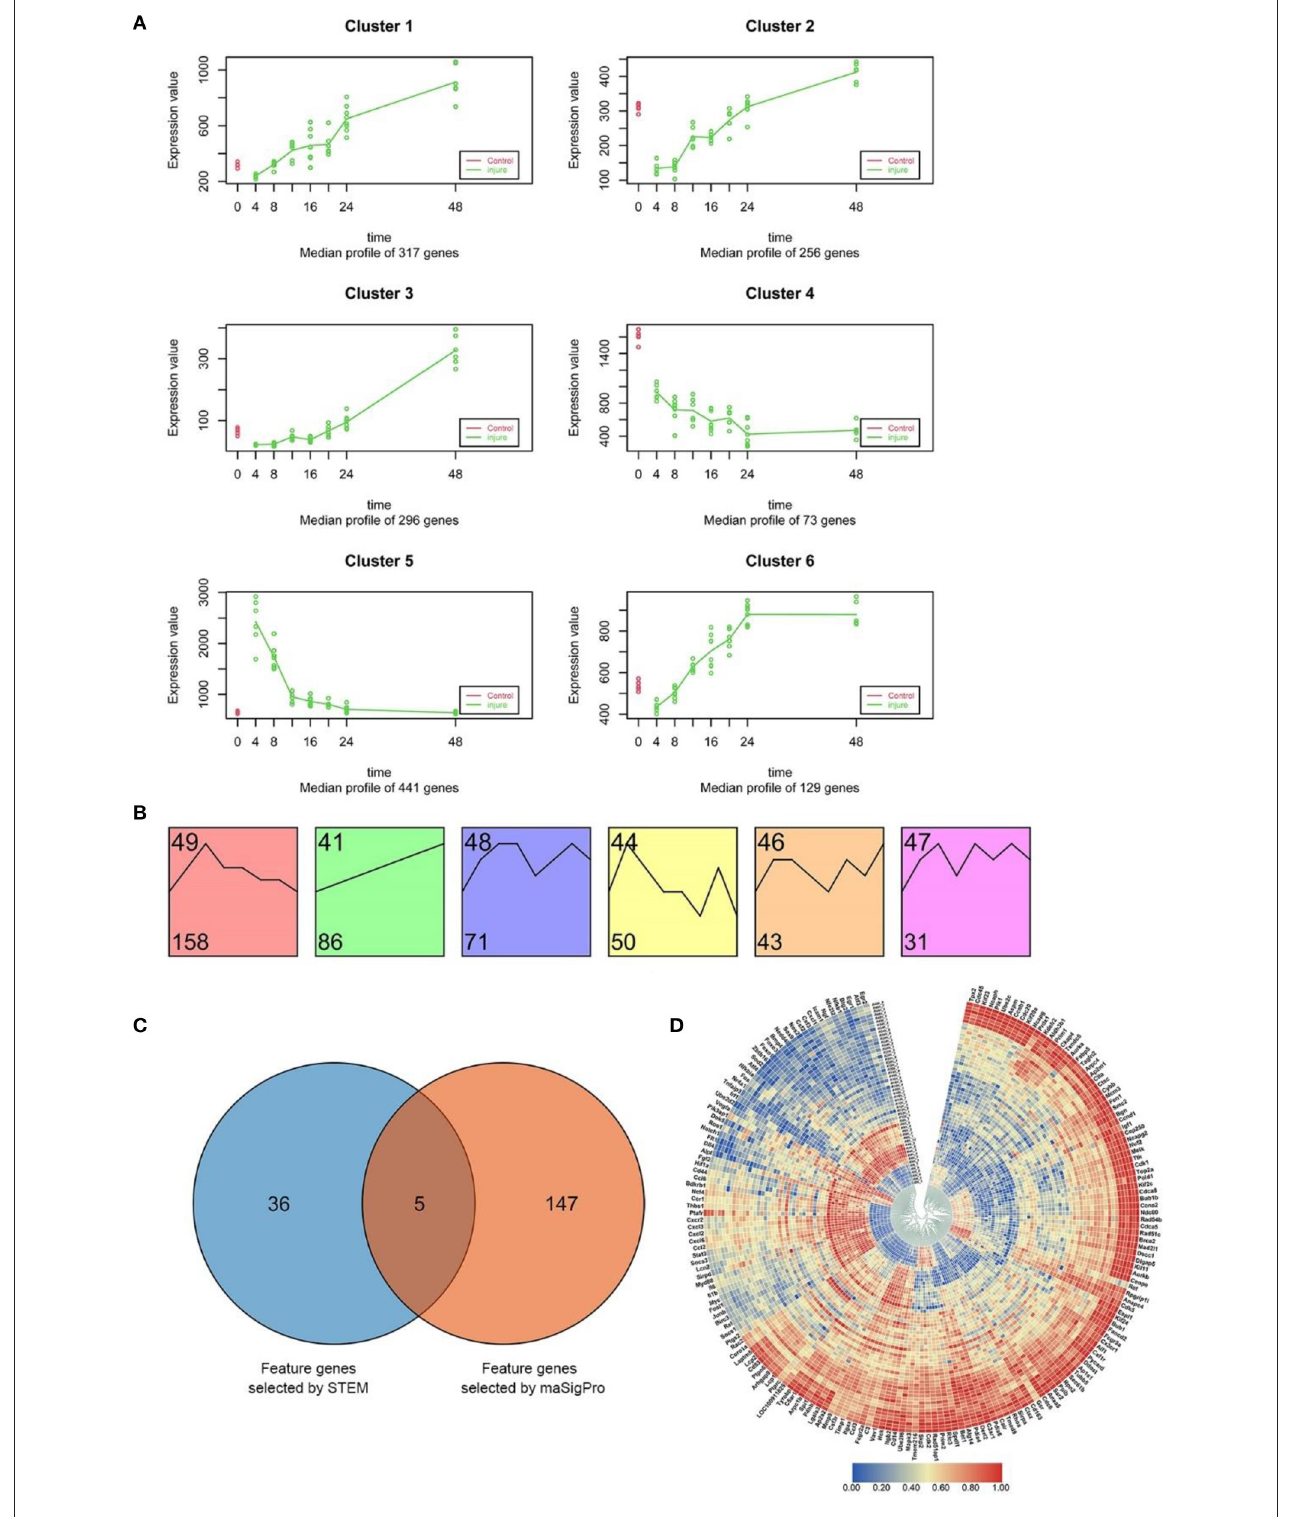
FIGURE 4 | Screening and functional analysis of time-dependent genes using STEM and maSigPro. (A) maSigPro results indicating the median gene expression profile for each cluster (green dots and lines represent injury groups; red dots and lines represent control groups). (B) STEM analysis of the 540 DEGs (between experimental and control groups) common to the seven experimental groups ( p < 0.001). The number at bottom left corner indicates the number of genes in each